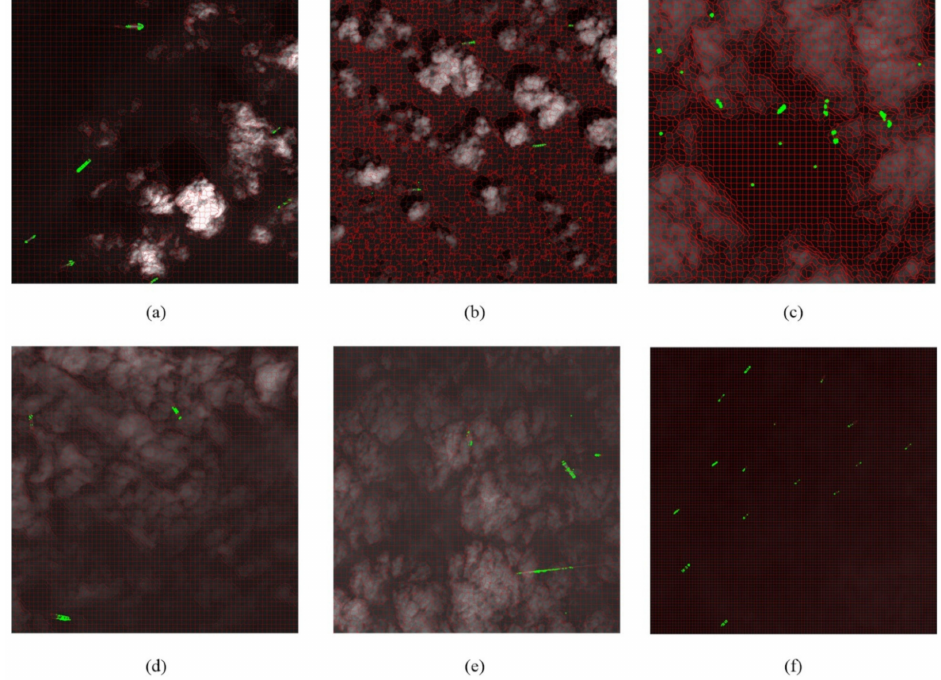
Figure 6. Feature point detection image. ( a – f ) are the feature points images using Figure 5a–f. Combined with superpixel segmentation and feature point detection, the divided superpixel target areas are merged into multiple blocks, and then judged as to whether it is a suspected target.